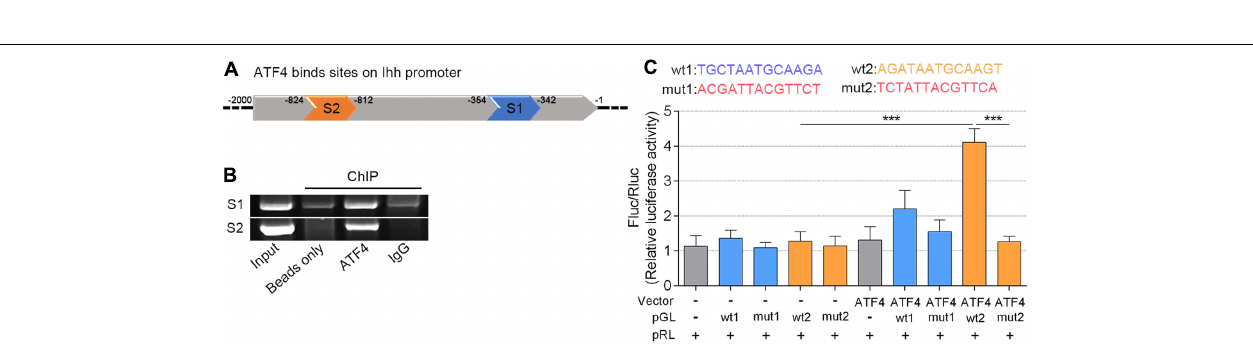
FIGURE 3 | ATF4 bound the Ihh gene promoter and promoted its expression of human NP cells. (A) Two predicted sites (S1 and S2) that ATF4 bound on the promoter region of Ihh. (B) AGE indicated two putative DNA sequences of Ihh immunoprecipitated by the anti-ATF4-coded beads. (C) Dual-luciferase reporter assay in NP cells co-transfected with the reporter plasmid and ATF4. Structural schematic of the wt and mutant sequences of S1 and S2 in the human Ihh promoter region is shown. Luciferase activity driven by the wt2 Ihh promoter was more pronounced following ATF4 treatment, and it was not driven by the mut2 luciferase reporter upon ATF4 treatment. In contrast, luciferase activity driven by the wt2 luciferase reporter decreased in the absence of ATF4. Luciferase activity showed no difference when driven by wt1 luciferase reporter. Data are presented as means ± SD ( n = 3). *** p < 0.001, - indicates not applied, and + indicates applied. ATF4, activating transcription factor 4; Ihh, Indian hedgehog; AGE, agarose gel electrophoresis; wt, wild type.